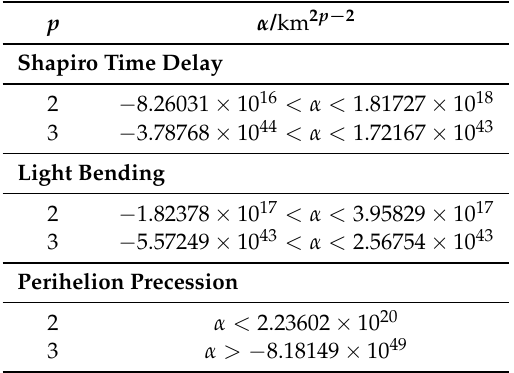
Table 3. A summary of the parameter constraints obtained for the coupling parameter, α , for the power-law model f ( T ) = T + α T p , where p = 2, 3 using observations from perihelion precession and the Cassini spacecraft. Here, M = M (cid:12) = 1.47km, R (cid:39) R (cid:12) = 6.9551 × 10 5 km, r ⊕ = 1.4710 × 10 11 km, = 4.6001 × 10 7 km, and r c = 5.55 × 10 7 r (cid:39)